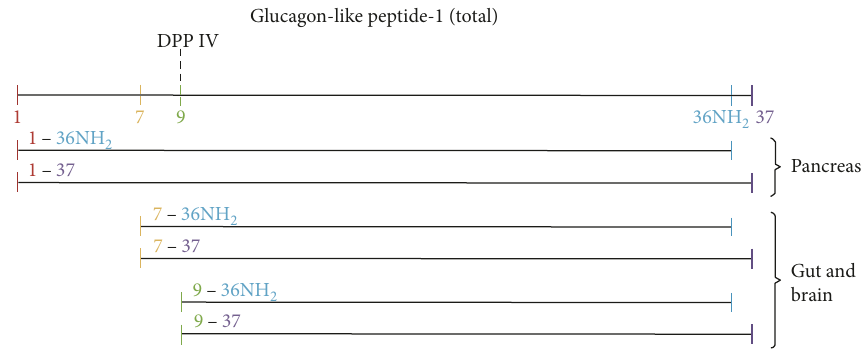
Figure 2: GLP-1 isoforms — illustration from Bak et al.